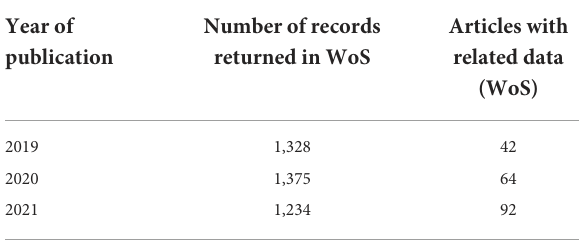
TABLE 1 Research articles in the ePubs repository indexed in the Web of Science that have DOIs (20 th April